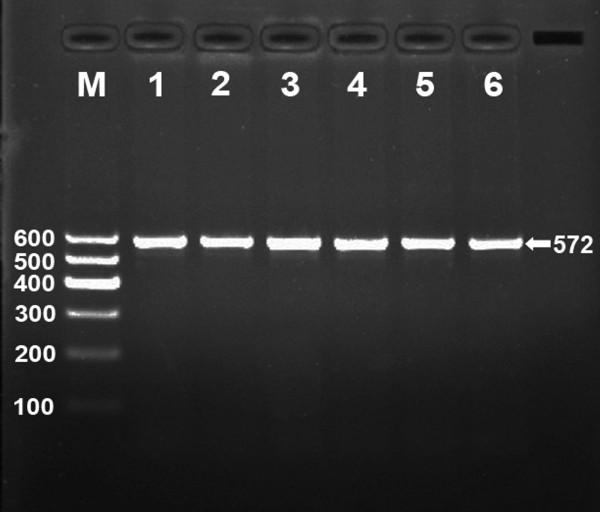
Electrophoresis of PCR products of the samples. Lane M, 100 bp marker ladder; lanes 1-6, samples. The 572 bp bands are the target genes.